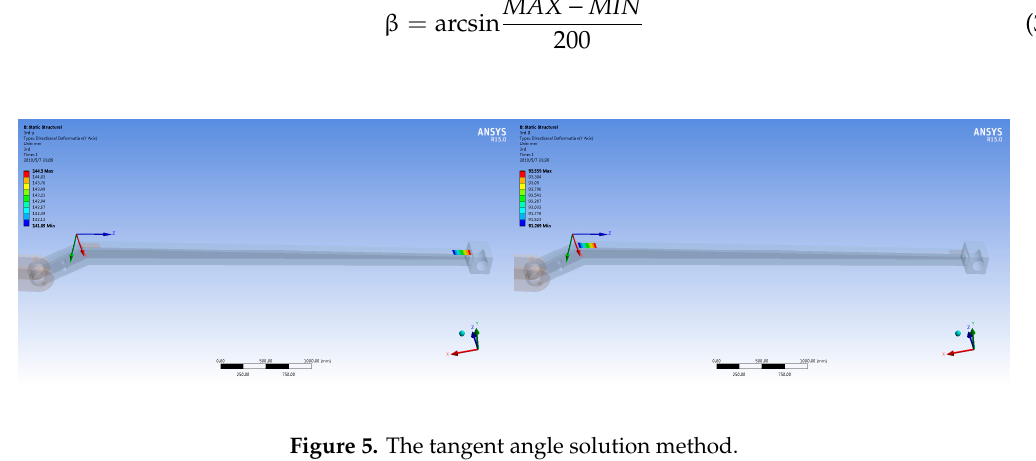
Figure 5. The tangent angle solution method.